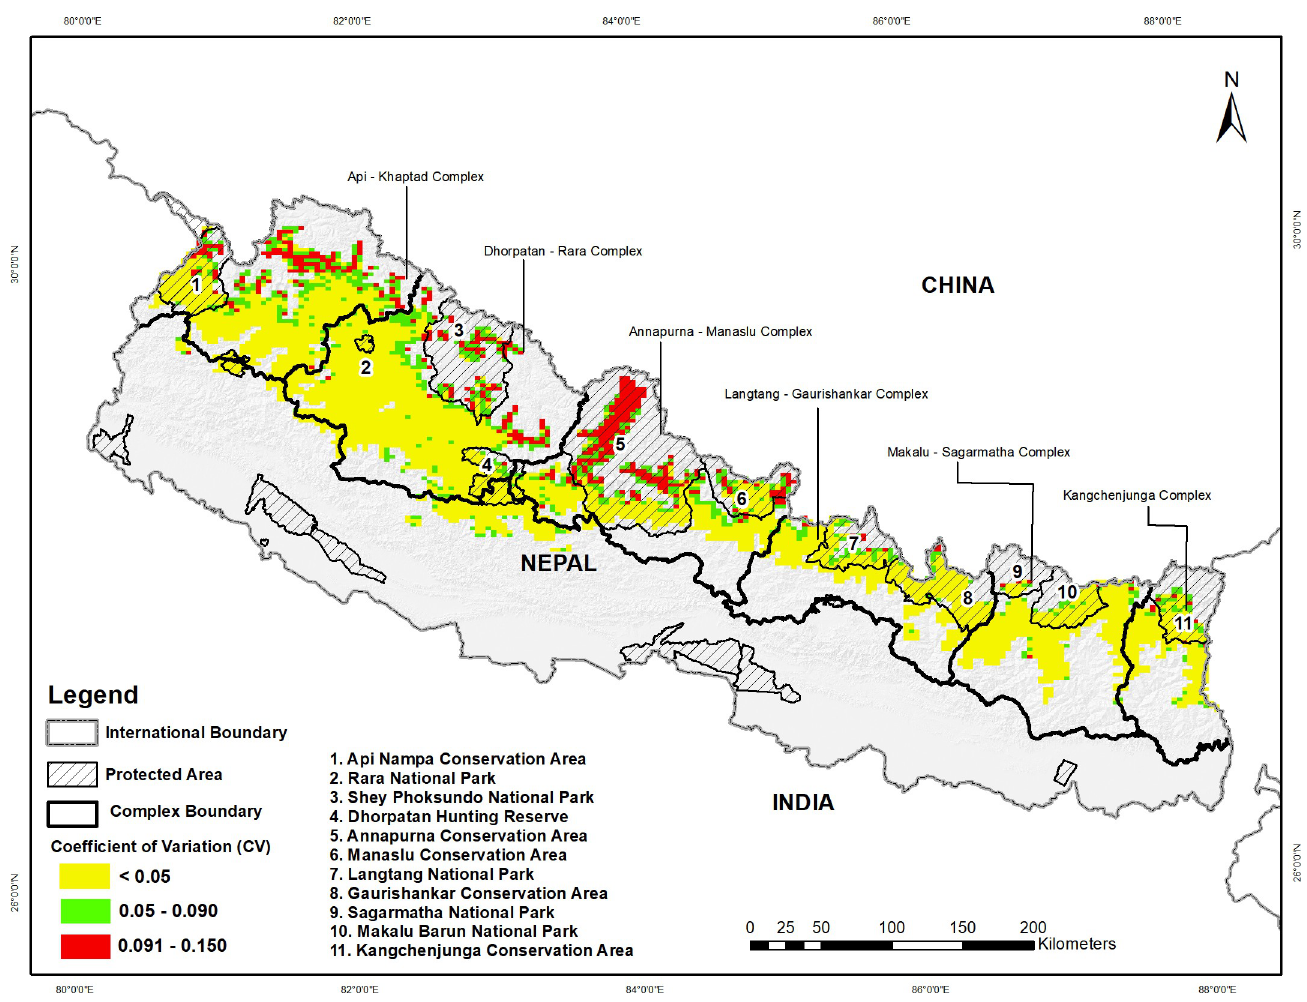
Fig 4. Variation (expressed in CV: Coefficient of variation, in %) in occupancy pattern based on estimated probabilities of occupancy in the wet season of 2016 using single-species, single-season occupancy model.